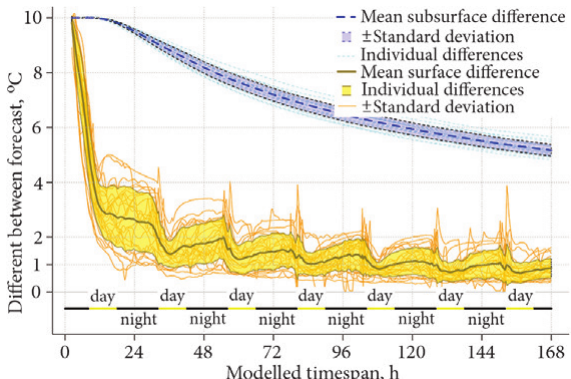
Fig. 4. Convergence of the surface and subsurface temperatures from the initial difference of 10